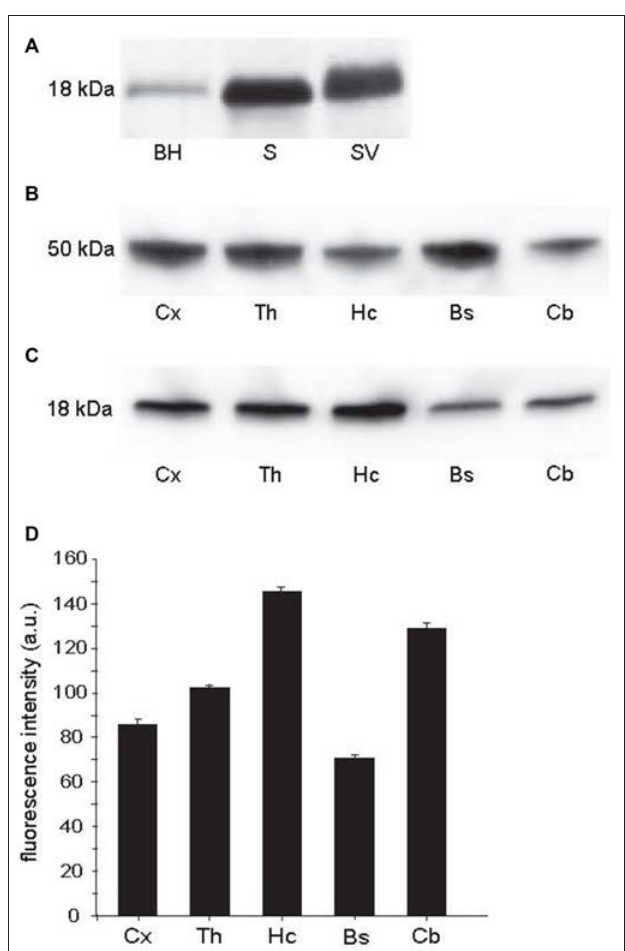
FIGURE 1 | Western blots from wild type rat brain. (A) BH: brain homogenate; S: crude synaptosomes; SV: synaptic vesicles. Protein loaded 30 µ g. (B) β -tubulin, used as loading control, in samples of homogenate from different brain regions. Protein loaded 20 µ g. (C) Syntaxin-1 in homogenate samples from different brain regions, i.e., cortex (Cx, mean: 86, STD: 5.29, SEM: 2.64), thalamus (Th, mean: 104, STD: 2.3, SEM: 1.67), hippocampus (Hc, mean: 147, STD: 5.15, SEM: 2.57), brain stem (Bs, mean: 71, STD: 5.92, SEM: 2.96) and cerebellum (Cb, mean: 129, STD: 5.22, SEM: 2.61). Protein loaded 20 µ g. (D) Quantitation of intensities of bands seen above, indicating highest concentration in the hippocampus, lowest in the brain stem. Error bars show SEM, based on four different